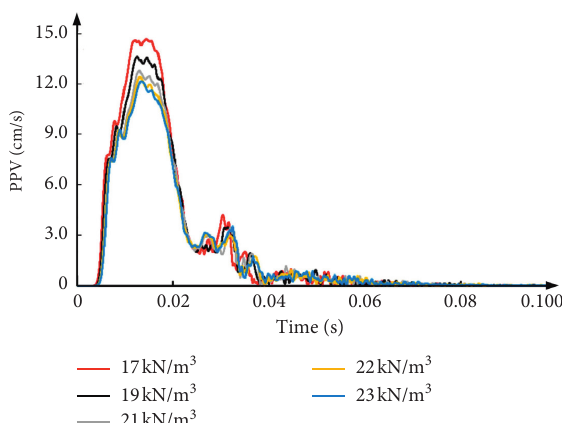
Figure 17: Changes of PPV of right wall with different bulk density versus time.